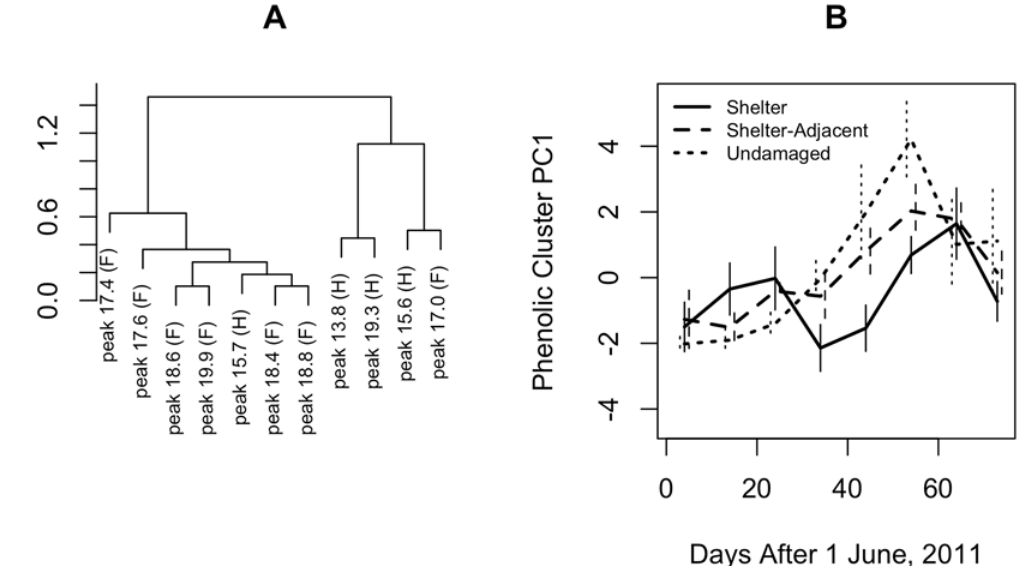
Fig 1. Chemical relationships between fern tissues vary seasonally. (A) Seven of the 11 phenolic compounds analyzed covaried in concentration across fern samples. Compounds are classified as flavonoids (F) or hydroxycinnamic acid derivatives (H). (B) The concentrations of these compounds in undamaged, shelter-derived, and shelter-adjacent fern tissues changed across the season, and the relative quantities in shelter-derived and undamaged fern tissues switched in the mid-summer.